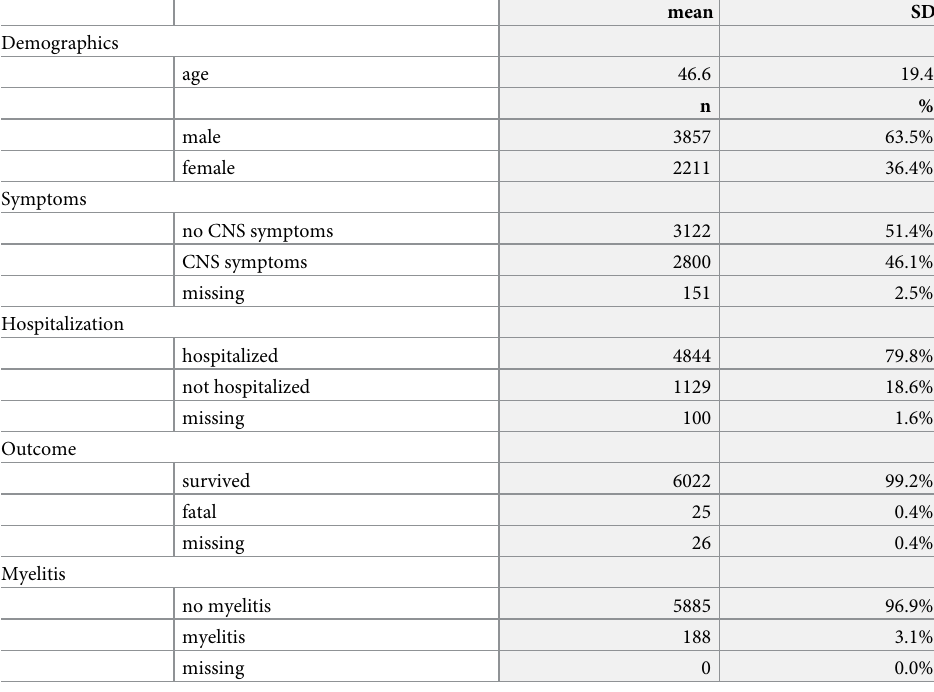
Table 1. Overview study population (N = 6,073) and dataset, general epidemiology.